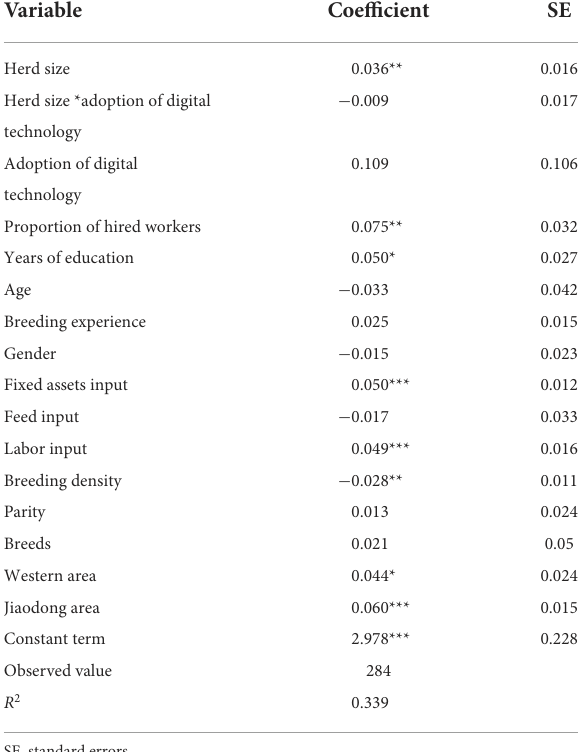
TABLE 3 Empirical results on the impact of digital technology adoption on the relationship between herd size and dairy cow yield by